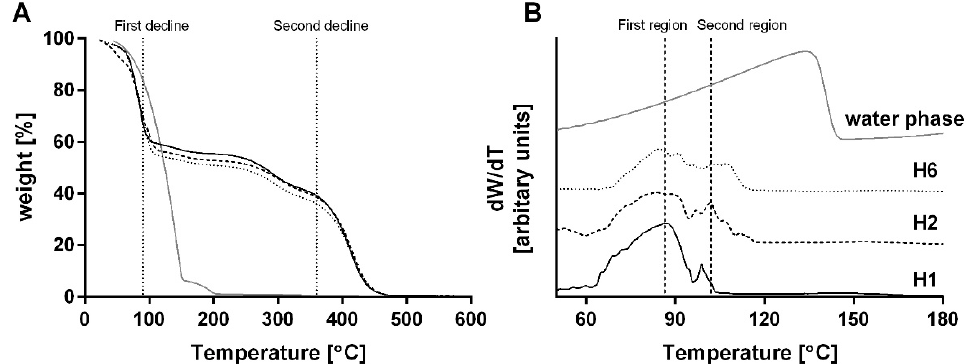
Figure 3. Thermogravimetric analysis (TGA) of H1 (black curve), H2 (dashed black curve), H6 (dotted gray curve), and water phase (gray curve) using a 10 °C min − 1 heating rate. ( A ) Percentage of weight as a function of temperature and ( B ) derivative of weight percentage by temperature as a function of temperature.